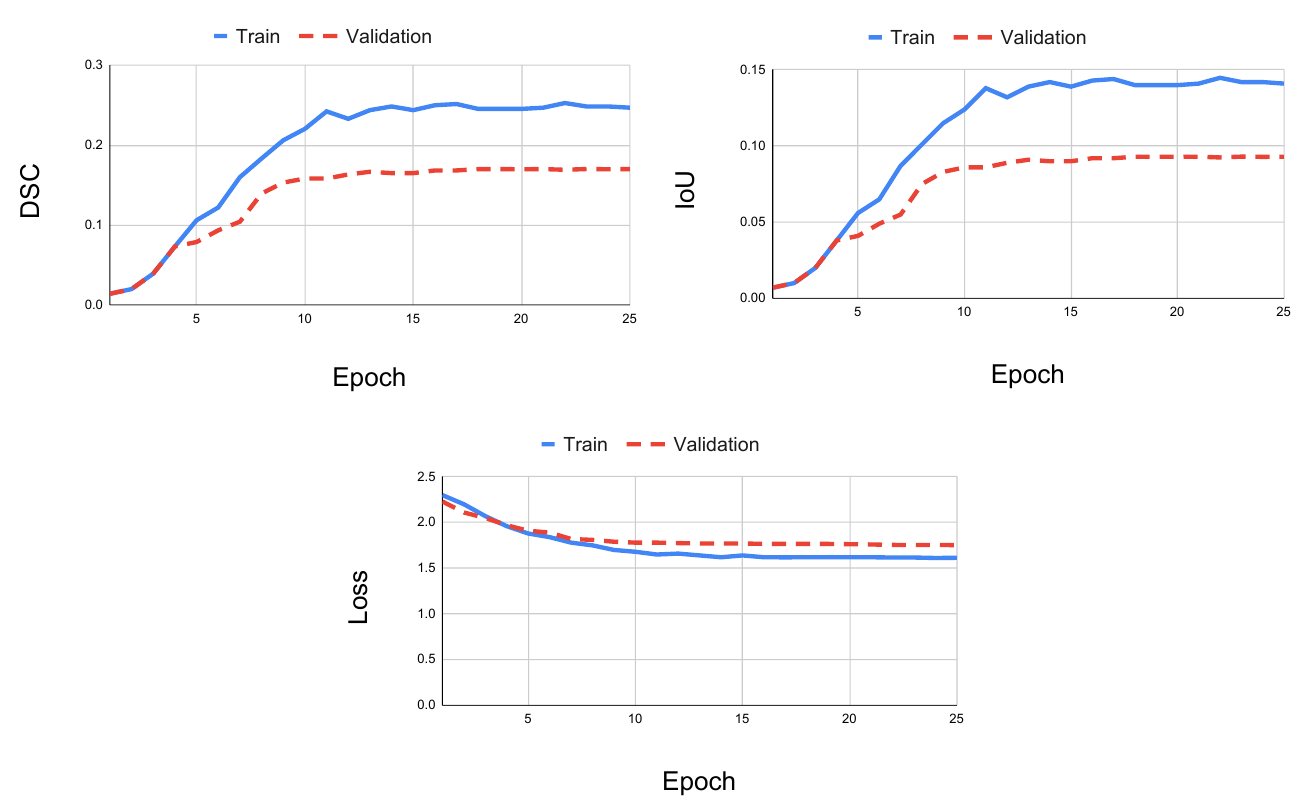
Figure 5. U-Net++ with ResNeXt-50 using the T1 sequence during training. Shown are the DSC, IoU, and loss per epoch during